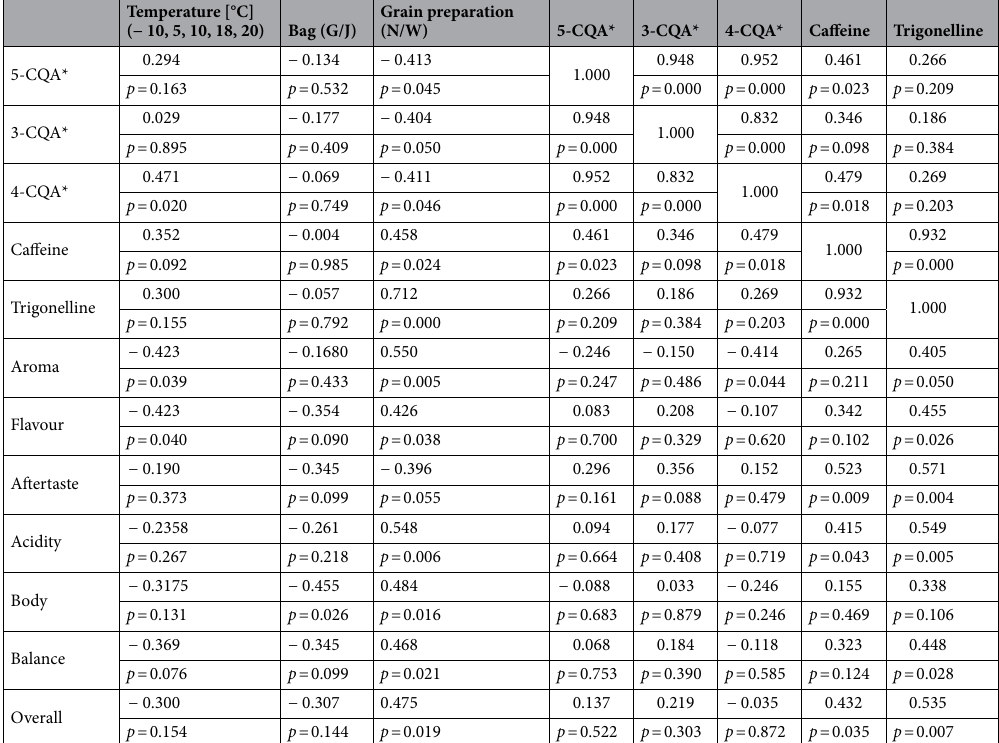
Table 2. Statistical correlations between individual parameters. Bold results: correlation coefficient with an absolute value greater than 0.4 and a p value < 0.05. G —GrainPro bag, J —jute bag, N —natural, and W — washed processed coffee bean, 5-CQA —5-O-caffeoylquinic acid, 4 - CQA —4-O-caffeoylquinic acid, 3-CQA — 3-O-caffeoylquinic acid.